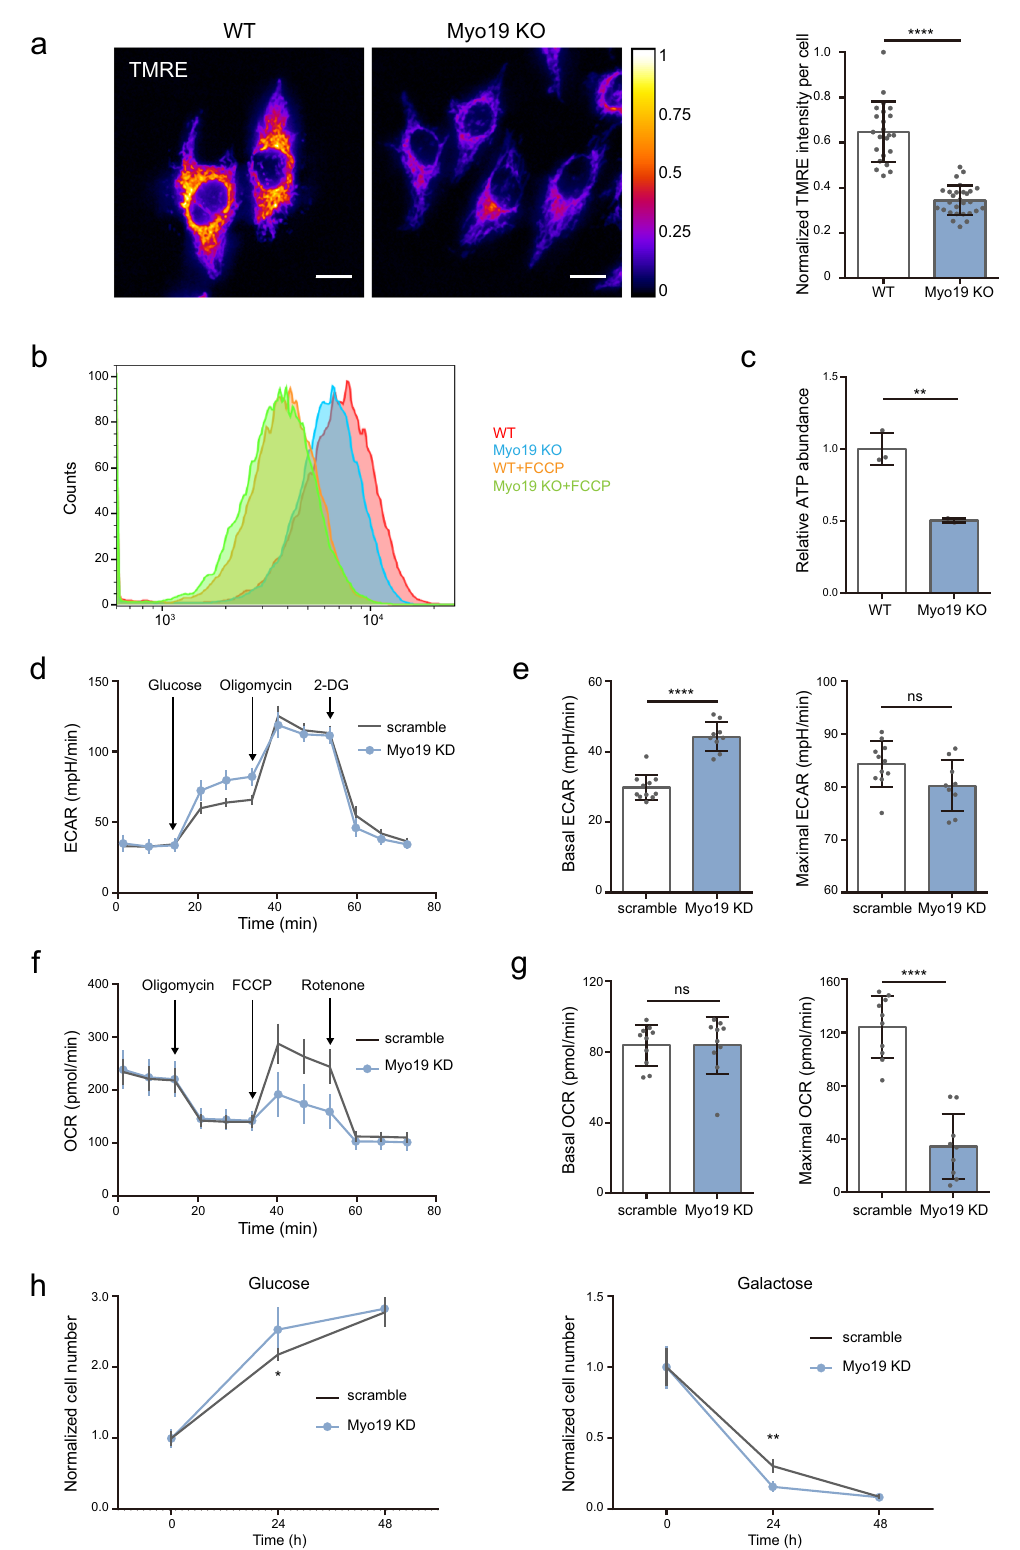
Methods coated coverslips or glass bottom dishes. For transfection, cells were transfected with Cell culture and DNA transfection . MDA-MB-231 cells were from ATCC pro- 2 μ g plasmid DNA in opti-MEM (31985-070, Invitrogen) containing 2 μ L Neofect ™ DNA transfection reagent (TF20121201) following the protocol for 24 – 48h. vided by Dr. Yujie Sun (Peking University) and HEK293T cells were provided by Dr. Yuxin Yin (Peking University). Cells were cultured in Dulbecco ’ s modi fi ed Eagle medium (LVN1001-1, Livning) supplemented with 10% fetal bovine serum (ST30- 3302, PAN), 100U/mL penicillin and 100 μ g/mL streptomycin (CC004, MAC- Fibronectin coating of coverslips . The 1mg/mL fi bronectin stock is diluted to GENE) at 37°C with 5% CO 2 . For imaging, the cells were seeded on the fi bronectin 10 μ g/mL with PBS. 50 μ L diluted fi bronectin solution is added to the φ 12 mm NATURE COMMUNICATIONS| (2022) 13:2673